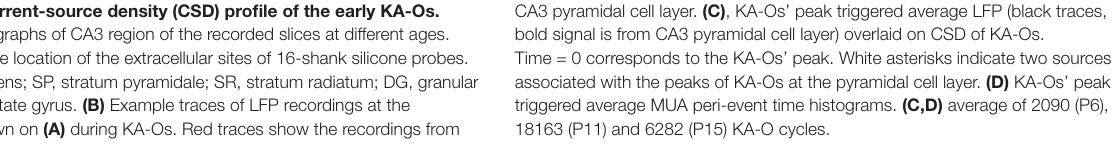
FIGURE 5 | Current-source density (CSD) profile of the early KA-Os. (A) Microphotographs of CA3 region of the recorded slices at different ages. Dots indicate the location of the extracellular sites of 16-shank silicone probes. SO, stratum oriens; SP, stratum pyramidale; SR, stratum radiatum; DG, granular cell layer of gentate gyrus. (B) Example traces of LFP recordings at the electrodes shown on (A) during KA-Os. Red traces show the recordings from